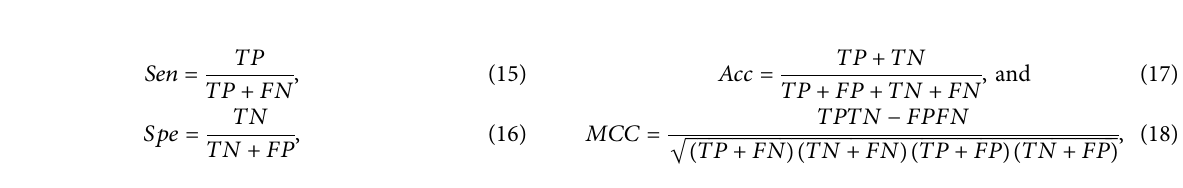
FIGURE3| Performanceofdifferentkindsfeatureson SVM,CNN, and C4.5.Cyan, orange, gray,yellow,blue, and green, respectively, represent theperformance of 3-mer, 4-mer, 5-mer, 6-mer, 7-mer, and 8-mer embedding features. Purple, pink, and red, respectively, represent the performance of 4, 5, 6-mer concatenated embeddings, 6, 7, 8-mer concatenated embeddings, and 3, 4, 5, 6, 7, 8-mer concatenated embeddings. (A,B) Performance of different kinds of feature on SVM. The standard deviation of SVM on 3-mer, 4-mer, 5-mer, 6-mer, 7-mer, 8-mer, 4, 5, 6-mer, 6, 7, 8-mer, and 3, 4, 5, 6, 7, 8-mer is in the range (0.001, 0.003), (0.001, 0.003), (0.001, 0.003), (0.001, 0.003), (0.001, 0.003), (0.001, 0.004), (0.001, 0.004), (0.001, 0.003), and (0.001, 0.003); (C,D) Performance of different kinds of feature on CNN. The standard deviation of CNN on 3-mer, 4-mer, 5-mer, 6-mer, 7-mer, 8-mer, 4, 5, 6-mer, 6, 7, 8-mer, and 3, 4, 5, 6, 7, 8-mer is in the range (0.003, 0.026), (0.008, 0.071), (0.006, 0.049), (0.015, 0.056), (0.016, 0.055), (0.016, 0.059), (0.008, 0.044), (0.011, 0.058), and (0.008, 0.045); (E,F) Performance of different kinds of features on C4.5. The standard deviation of CNN on 3-mer, 4-mer, 5-mer, 6-mer, 7-mer, 8-mer, 4, 5, 6-mer, 6, 7, 8-mer, and 3, 4, 5, 6, 7, 8-mer is in the range (0.005, 0.545), (0.007, 0.531), (0.005, 0.049), (0.007, 0.685), (0.003, 0.440), (0.007, 0.489), (0.008, 0.630), (0.006, 0.567), and (0.005,